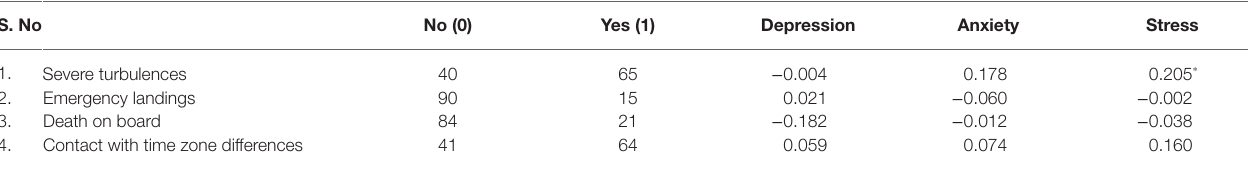
TABLE 4 | Correlations of experiencing serious events and contact with time differences with DASS-scores, sample 1 May 2019. S. No Anxiety 1. Severe turbulences